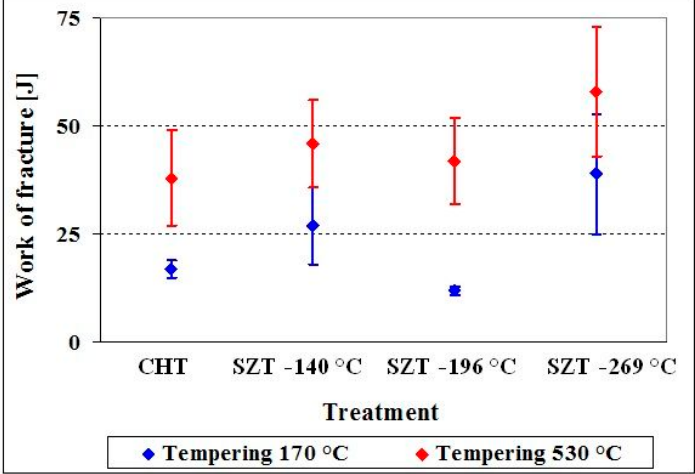
Metals 2018 , 8 , x FOR PEER REVIEW Figure 8. Work of fracture W of for CHT and differently SZT treated specimens made of Vanadis 6 steel. Figure 8. Work of fracture W of for CHT and differently SZT treated specimens made of Vanadis 6 steel. Figure 8. Work of fracture W of for CHT and differently SZT treated specimens made of Vanadis 6 steel.